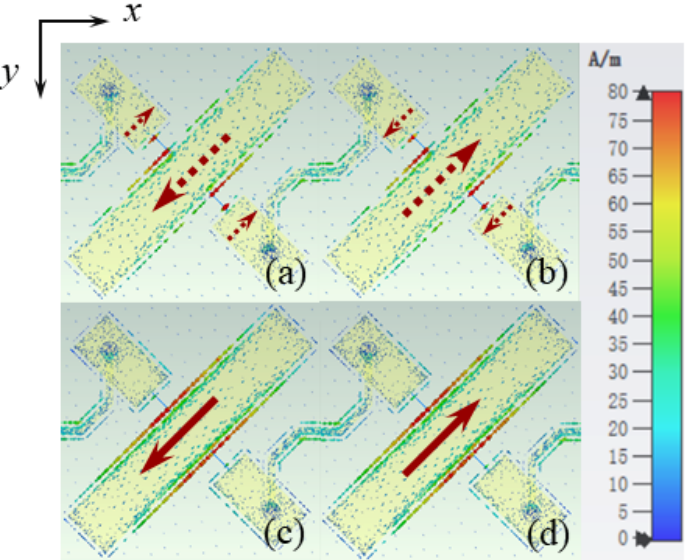
Figure 6. Simulated surface current distributions of the APCM unit cell when ( a ) f = 8.25 GHz, PIN on, x-polarized incident ( b ) f = 8.25 GHz, PIN on, y-polarized incident ( c ) f = 10.64 GHz, PIN off, x-polarized incident ( d ) f = 10.64 GHz, PIN off, y-polarized incident.